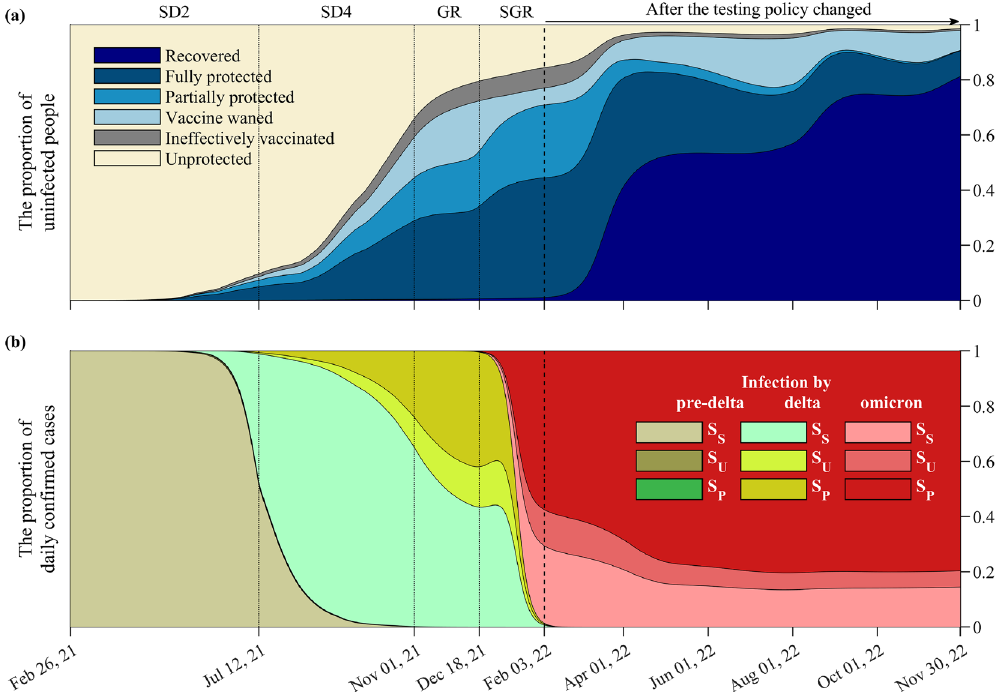
Figure 3. The proportion of ( a ) non-infected and ( b ) infected classes from February 26, 2021 to November 30, 2022. The black dotted lines depict the transition between the different SD policies. The solid black line on February 3, 2022 indicates the end of the estimation period and the start of the forecast